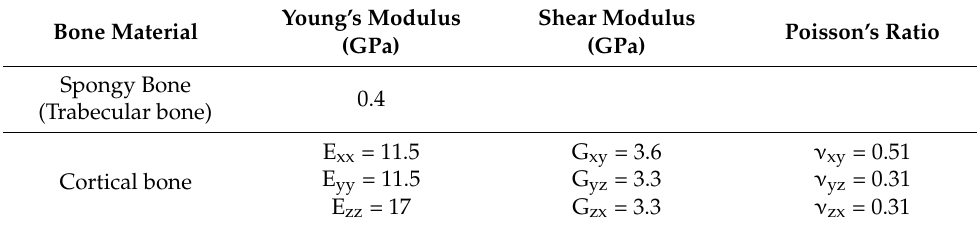
Figure 3. Stemmed femur complete finite element model with applied physiological loads. Table 2. Femur material properties utilized for the finite element model [8,35].